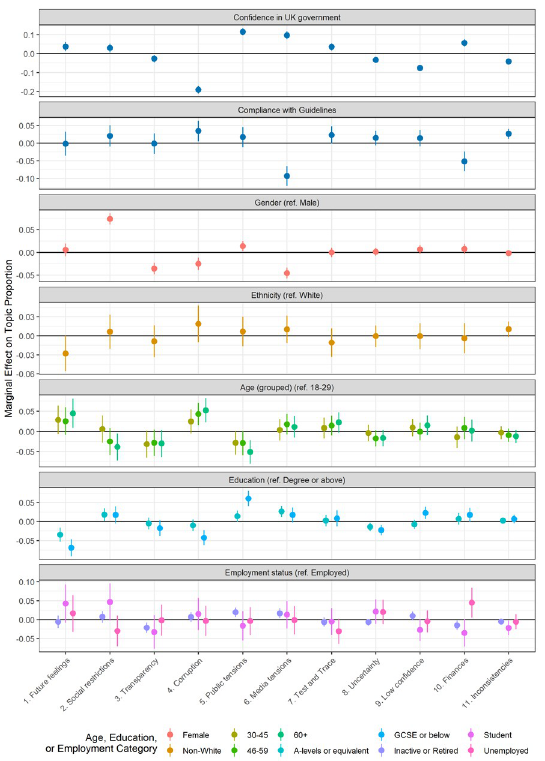
Fig 4. Association between topic proportions and person characteristics (+ 95% CIs). Drawn from multivariate regression models. Continuous variables scaled to 0–1 range, so estimate reflects estimated change in topic proportion due to increase from minimum to maximum value.